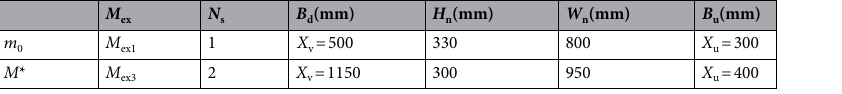
Table 5. Comparison of main design parameters or sub-models of aircraft before and after